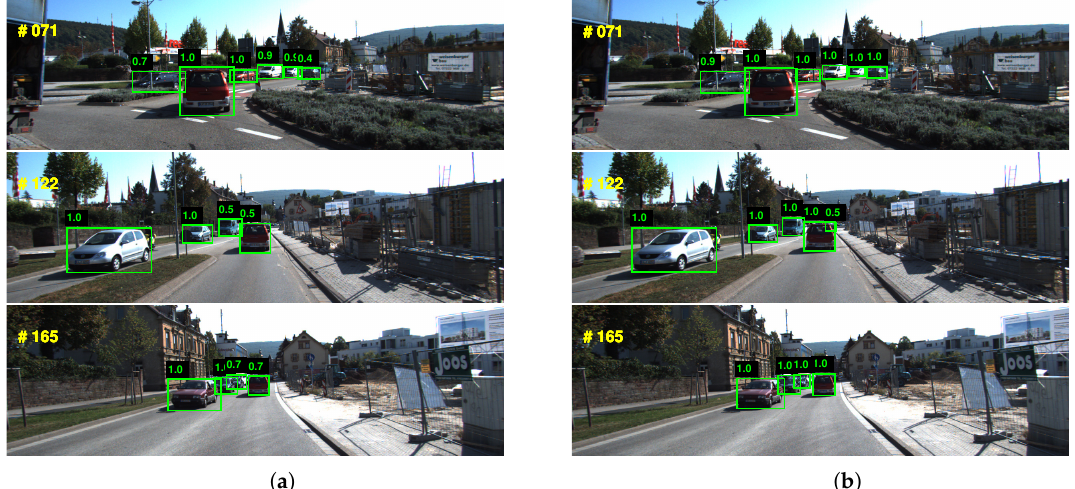
Figure 6. The left column ( a ) shows the results of the fine-tuned SSD, and the right column ( b ) shows the results of the fine-tuned SSD augmented with temporal ROIs. Compared with the fine-tuned SSD, the temporally augmentation based method increases the confidence of positive detections and for small objects.